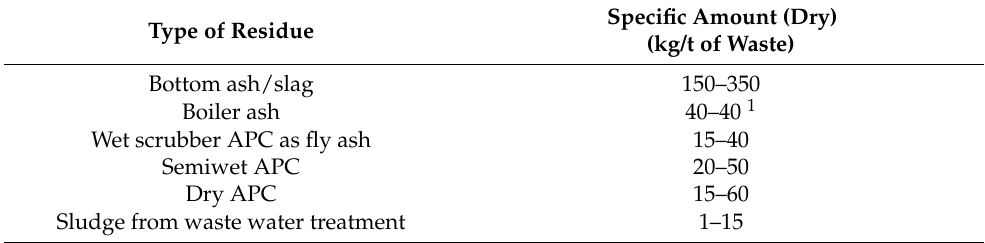
Table 3. Typical data of the residues arising from waste incineration plants